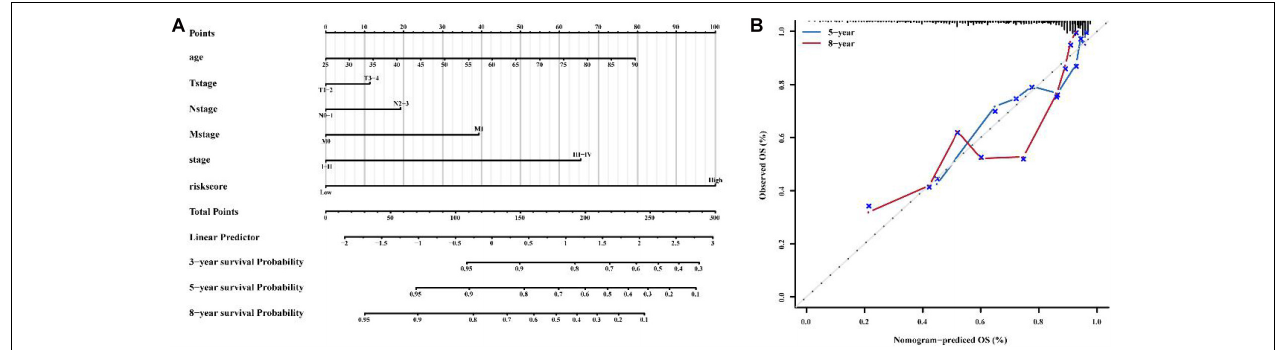
FIGURE 9 | Construction of a nomogram to predict the OS of patients with BC. (A) nomogram to predict survival probability at 1, 3, 5 and 8 years for BC. (B) Calibration curve with Hosmer-Lemeshow test of the nomogram.